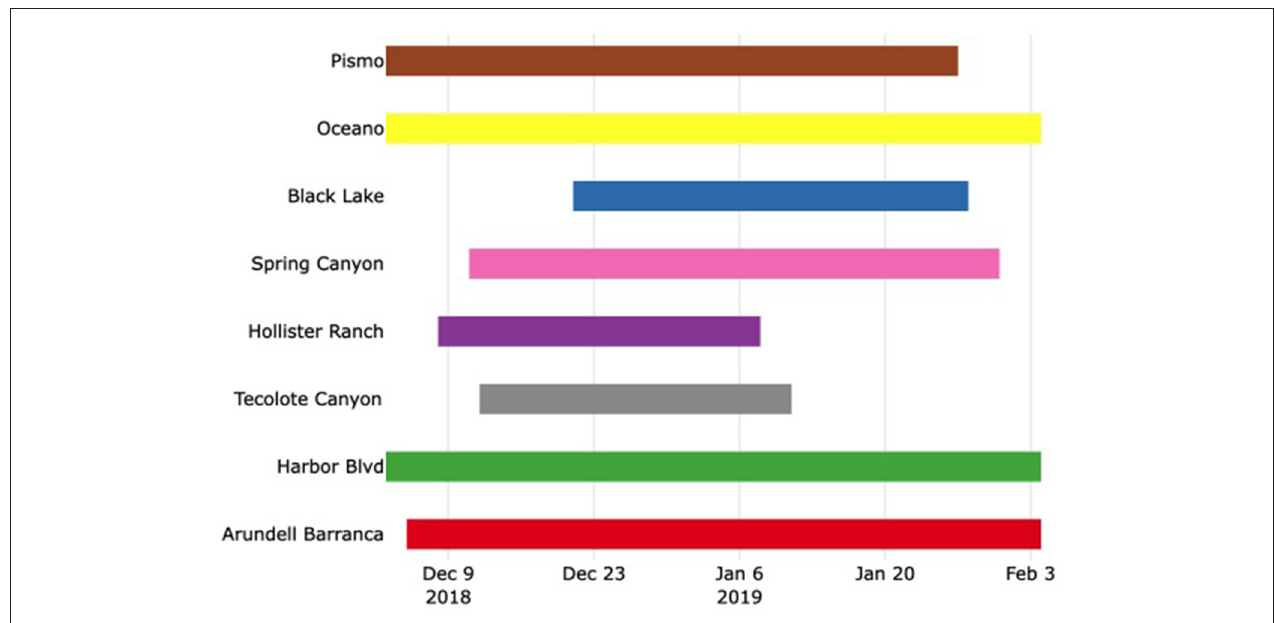
FIGURE 2 | Start and end dates for data collection for each grove in the study. The start dates were delayed awaiting 1,000 or more monarchs per grove and varied as a function of monarch presence and counts and by access availability once the monarchs were present. The end dates were defined by monarchs departing entirely from a grove. The shortest sampling period was 30 days, and the longest was 61 days (mean = 43